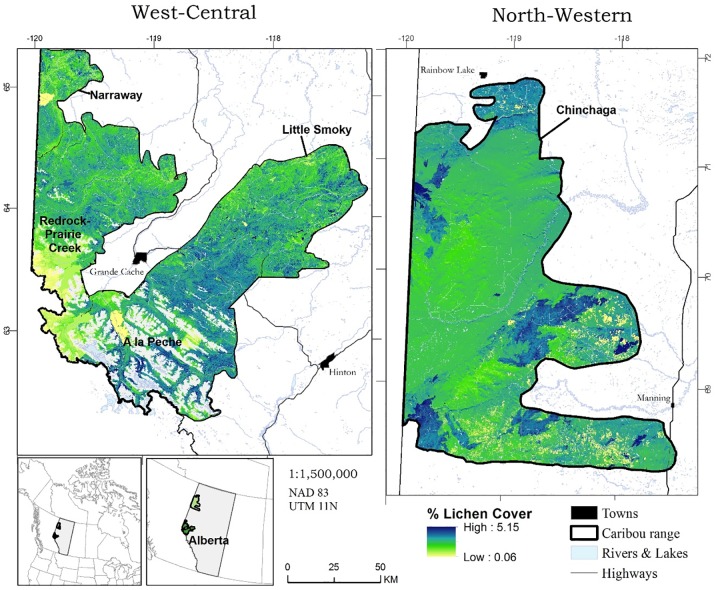
Map of predicted terrestrial lichen cover.Predicted terrestrial lichen cover (Cetraria spp., Cladina spp., Cladonia spp. and Flavocetraria spp.) in west-central and north-western Alberta, Canada, mapped using landscape conditions in 2017. Blank areas within caribou range in west-central denote rock and ice covered mountain tops.